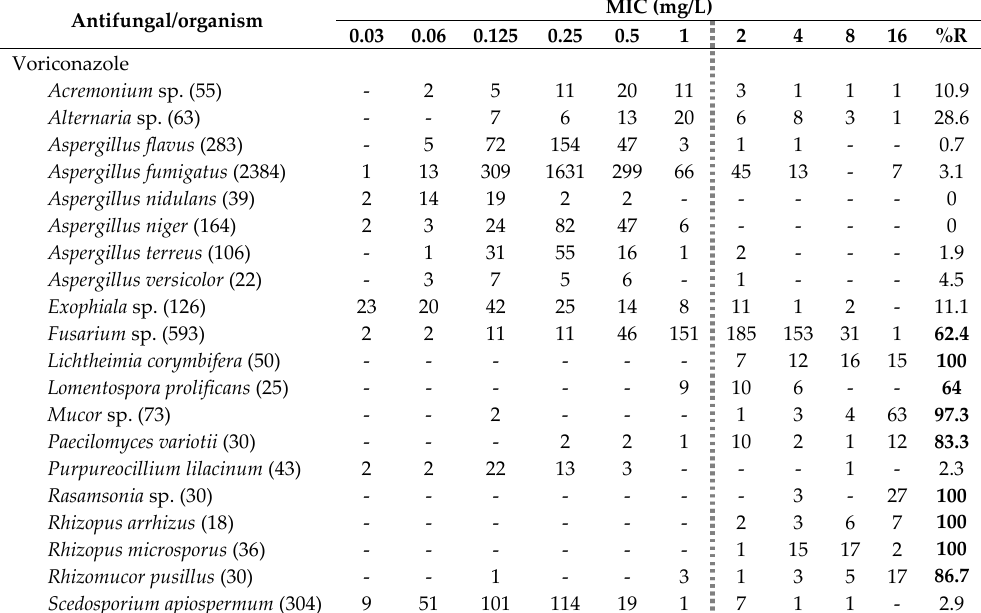
Table 4. MIC distributions for voriconazole. For presentation conventions, see Legend to Table